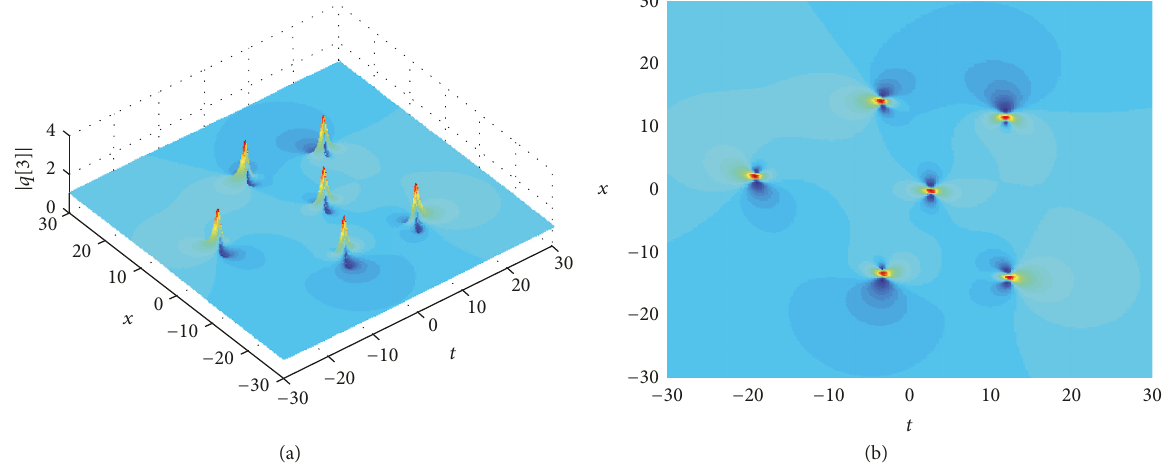
Figure 8: (a) The third-order rogue wave with 𝜀 = 0.02 , 𝑏 1 = 500 , and 𝑏 2 = 10000 ; (b) the density plot with 𝜀 = 0.02 , 𝑏 1 = 500 , and 𝑏 2 = 10000